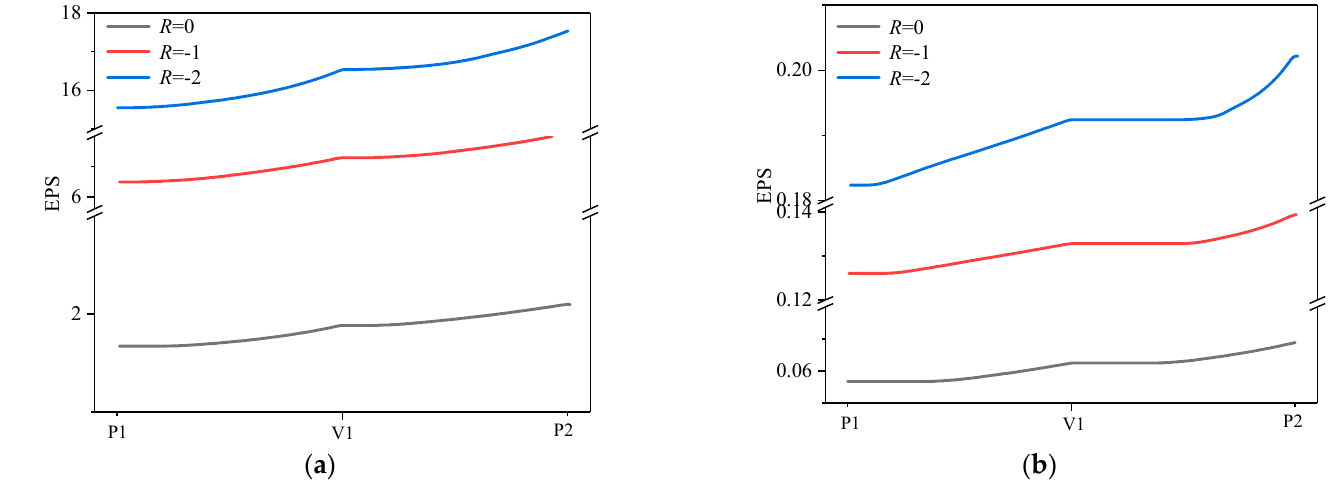
Figure 17. EPS field with loading history: ( a ) β = 0°, ( b ) β = 60°.